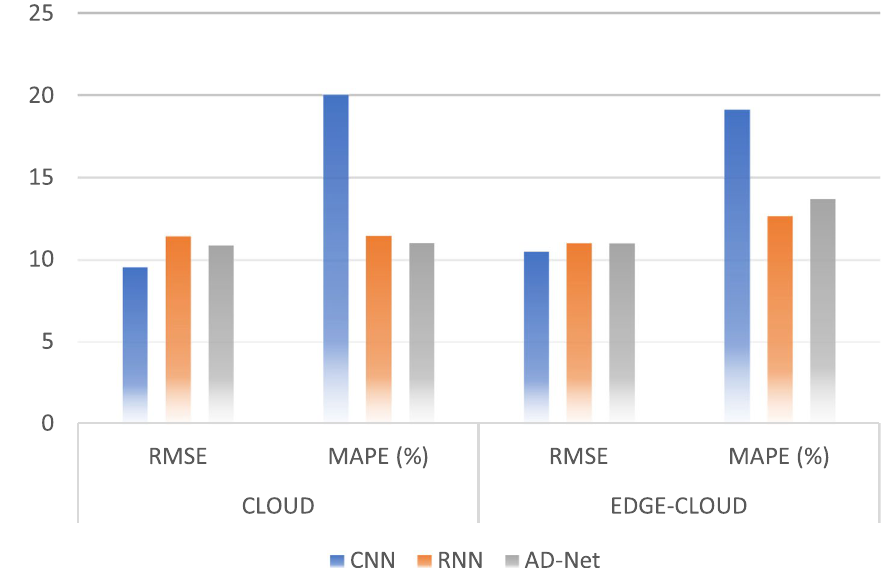
Fig. 11 Accuracy of various deep learning methods using cloud and edge-cloud